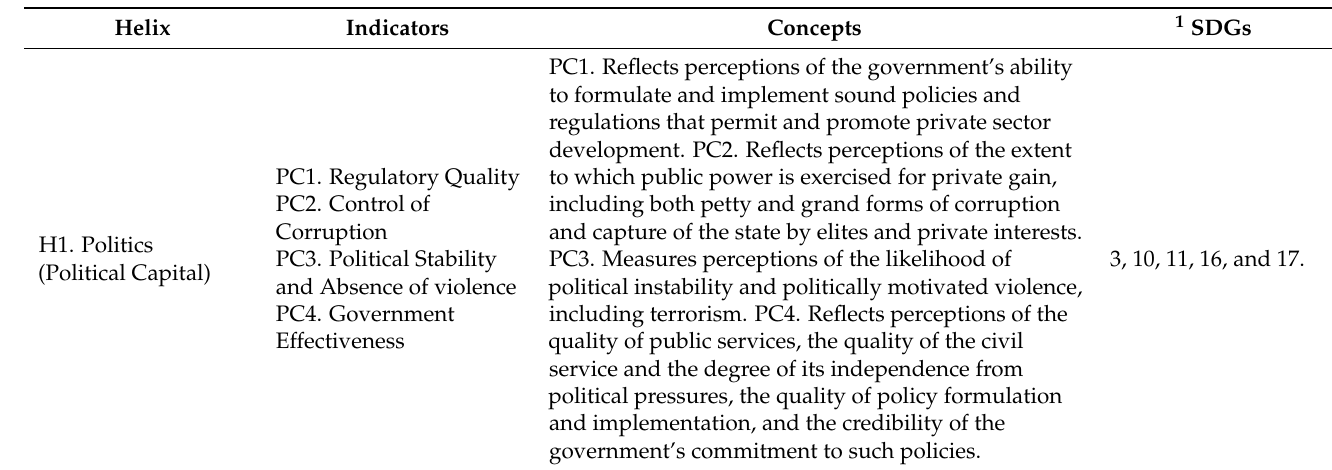
Table A2. Analysis